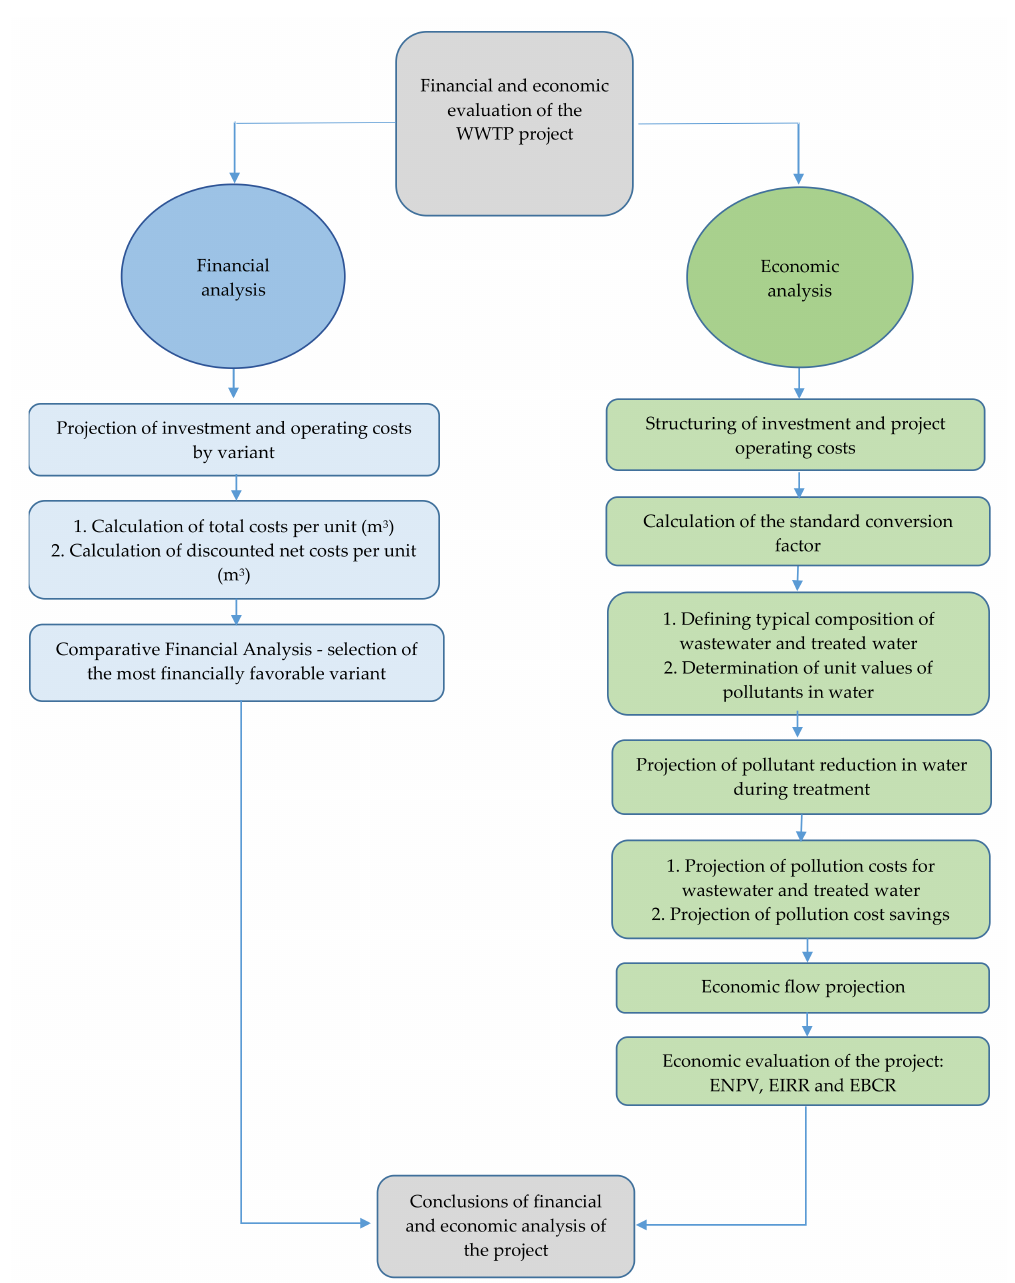
Figure 2. Methodological